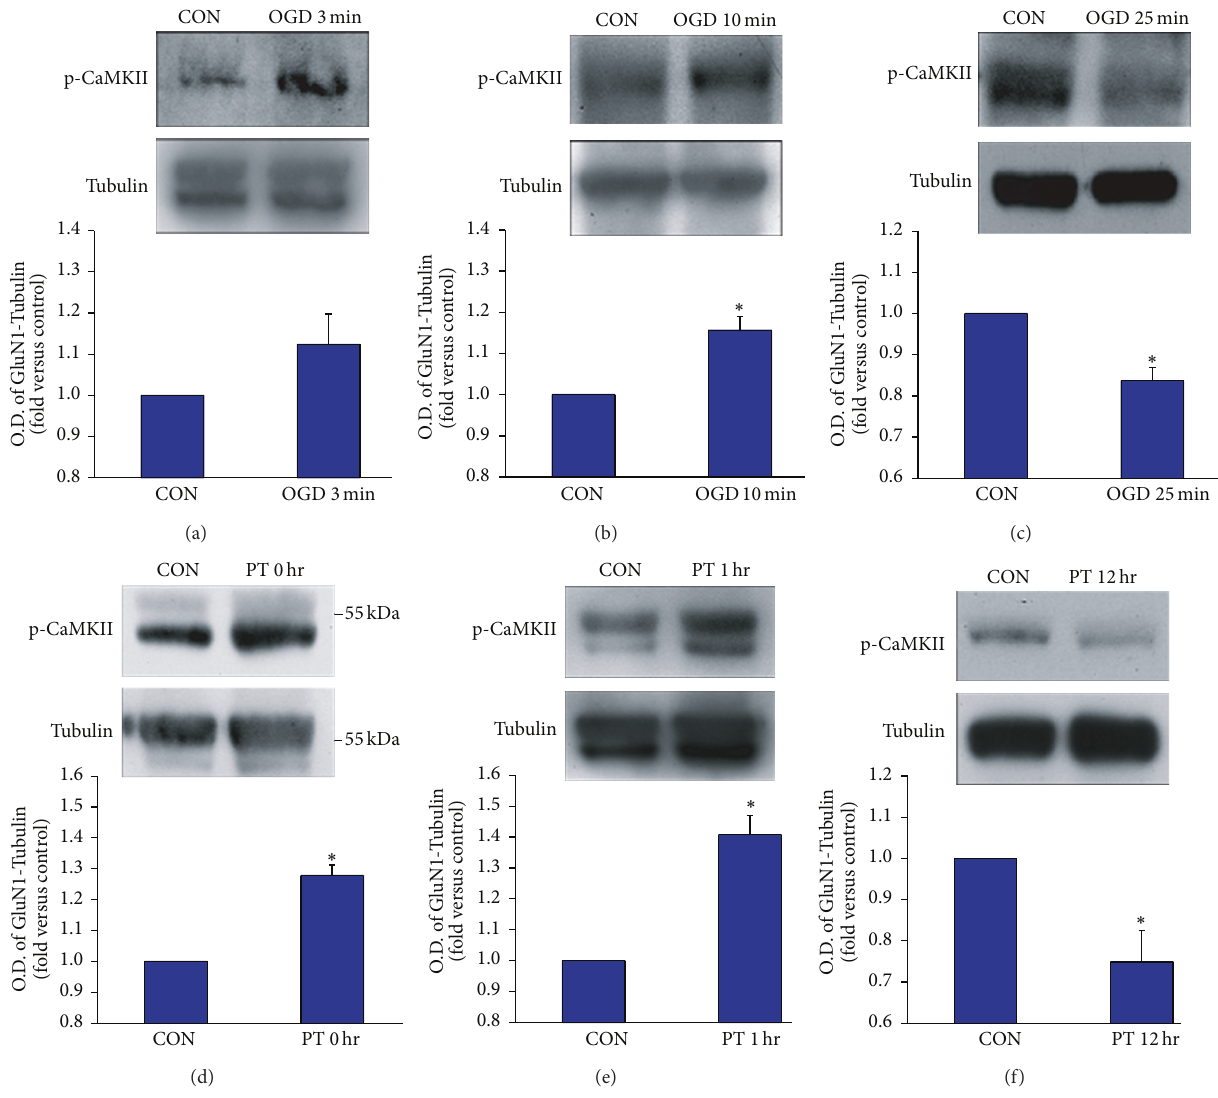
Figure 4: ((a)–(c)) The influence of OGD treatment on autophosphorylation of CaMKII (3min OGD, 1.12 ± 0.07 , 𝑛 = 5 , 𝑃 > 0.05 ; 10min OGD, 1.16 ± 0.03 , 𝑛 = 3 , ∗ 𝑃 < 0.05 ; 25 min OGD, 0.84 ± 0.03 , 𝑛 = 5 , ∗ 𝑃 < 0.05 ). ((d)–(f)) The influence of OGD treatment on autophosphorylation of CaMKII (0hr after PT, 1.28 ± 0.03 , 𝑛 = 4 , ∗ 𝑃 < 0.05 ; 1hr after PT, 1.41 ± 0.06 , 𝑛 = 5 , ∗ 𝑃 < 0.05 ; 12hr after PT, 0.75 ± 0.08 , 𝑛 = 5 , ∗ 𝑃 < 0.05